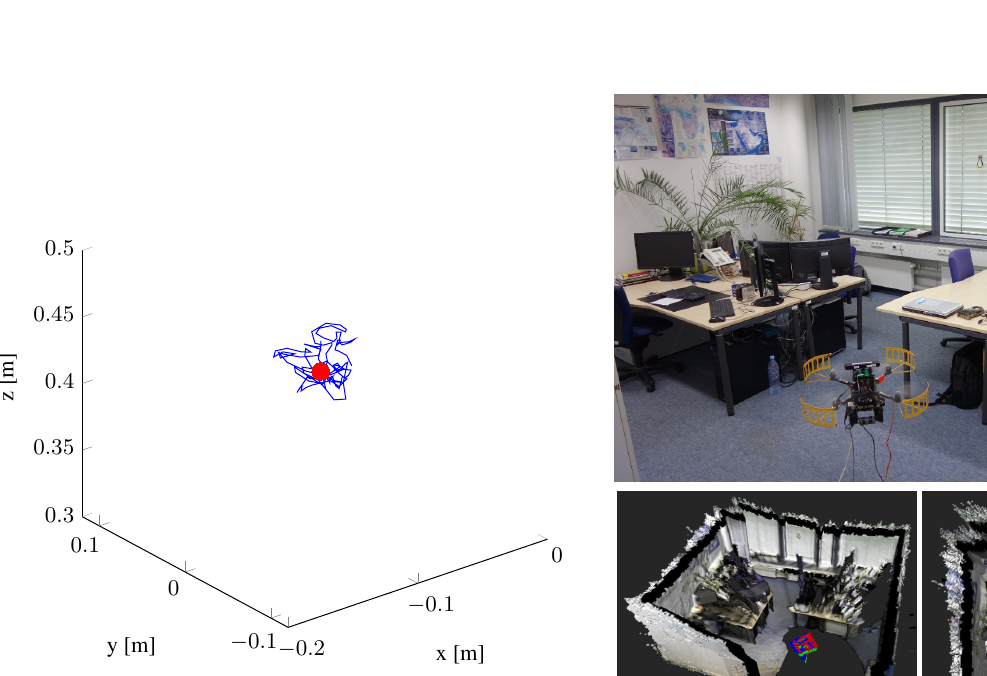
Figure 4: Hovering experiment using the position information from the proposed approach. The average deviation from the set point was 2.1cm. Blue: Estimated position of the quadrocopter. Red: Goal location.